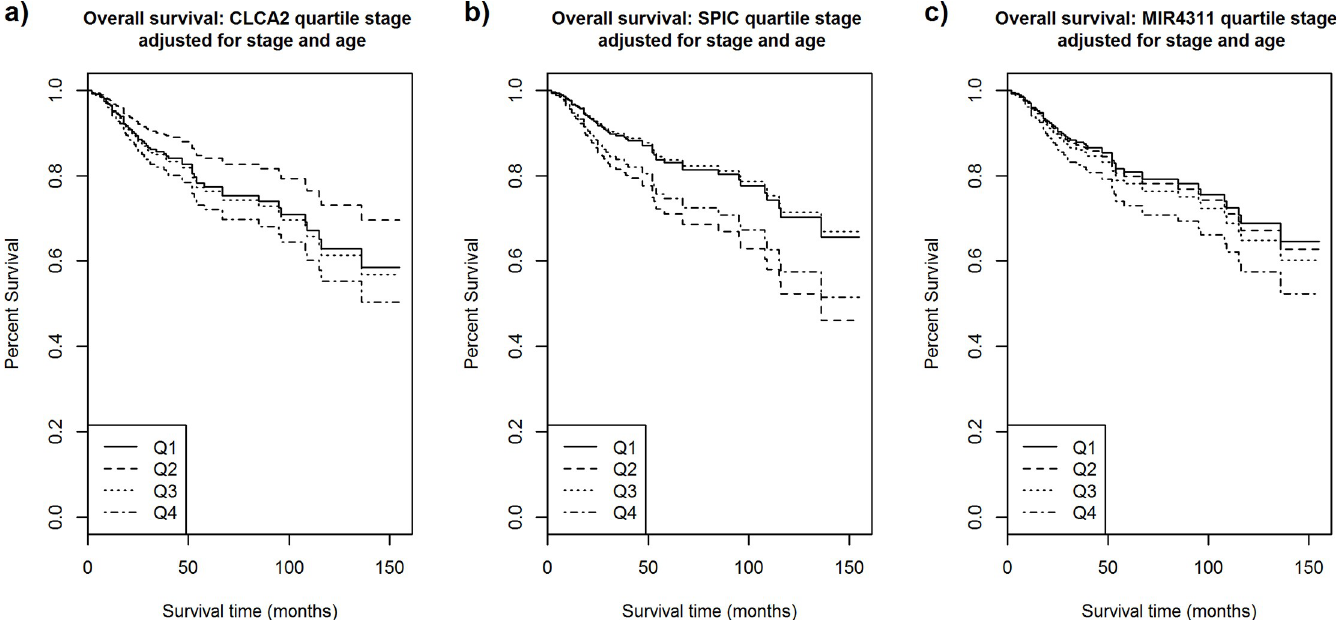
Fig 1. Kaplan-Meier survival curves by CLCA2, SPIC, and MIR4311 quartile in the Detroit AA cohort. Kaplan − Meier plots for overall survival by (a) CLCA2 quartile, (b) SPIC quartile, and (c) MIR4311 quartile among 155 treatment-na ï ve TN tumors (56 deaths) in the Detroit AA cohort. Solid lines represent curves for Q1, dashed lines represent curves for Q2, dotted lines represent curves for Q3, and dash-dotted lines represent curves for Q4 in each panel.